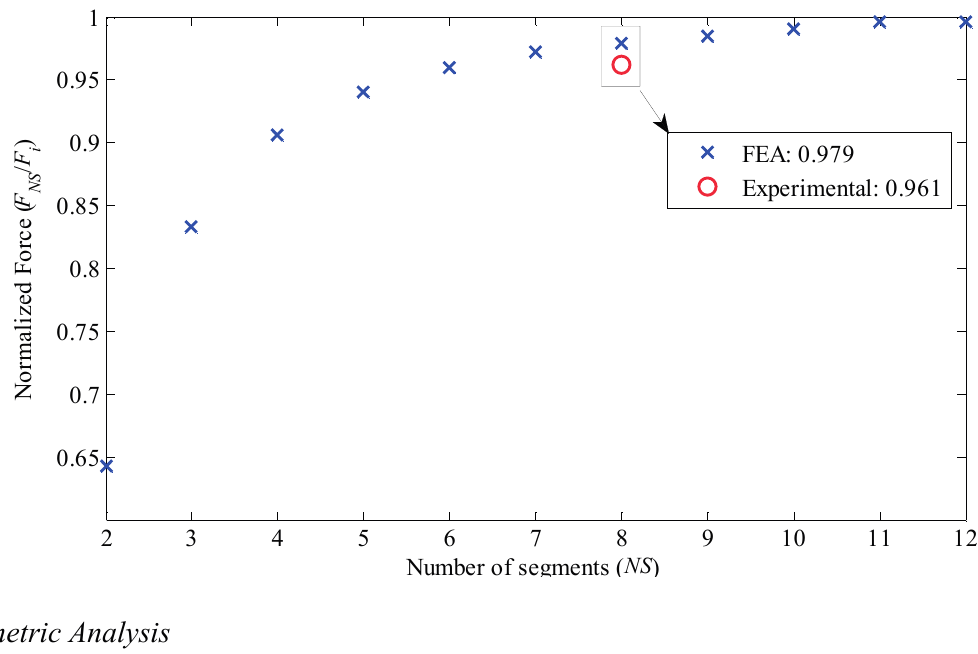
Figure 12. Results of normalized axial force produced by the actuator with parallel magnetized permanent magnets. Values were normalized in relation to an actuator with ideal radial magnetized permanent